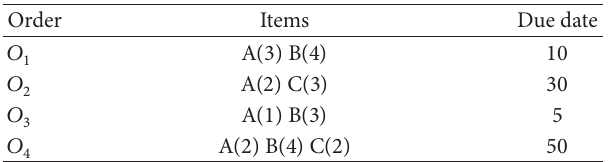
Table 1: Order-item data.